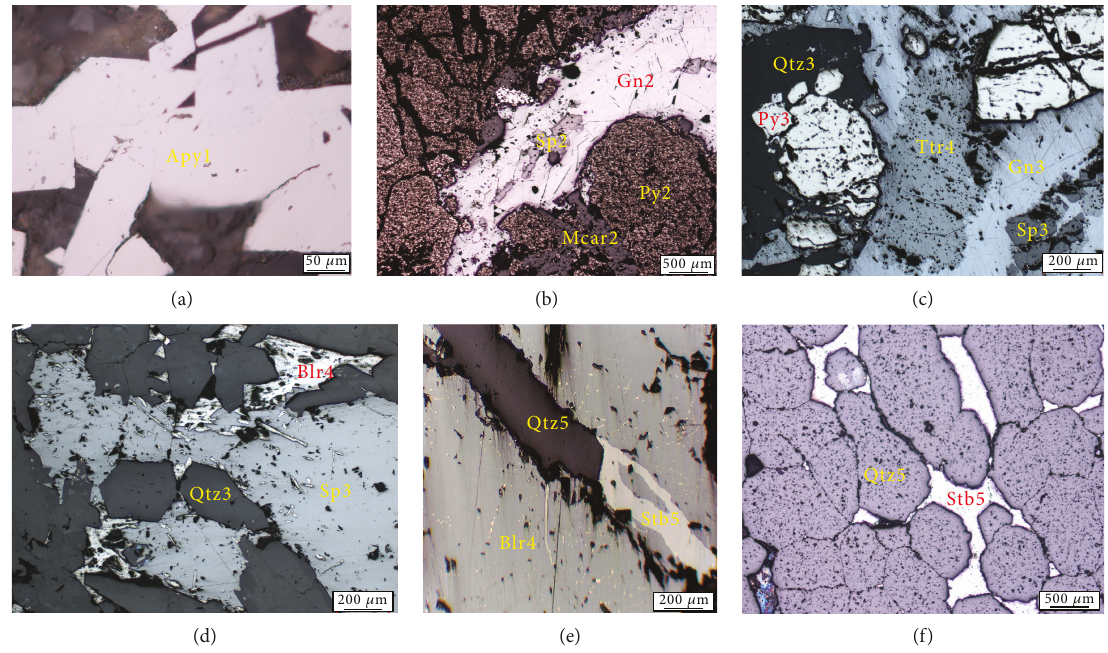
Figure 5: Photomicrographs of representative samples from the Keyue Sb – Pb – Zn – Ag deposit. (a) Assemblage 1 automorphic arsenopyrite. (b) Later formed assemblage 2 galena cut and replaced early formed sphalerite – pyrite – Mn – Fe carbonate. (c) Assemblage 4 tetrahedrite replaced assemblage 3 pyrite – sphalerite – galena – quartz. (d) Assemblage 4 boulangerite replaced assemblage 3 sphalerite – quartz. (e) Assemblage 5 quartz – stibnite vein cut the assemblage 4 boulangerite. (f) Assemblage 5 stibnite occurred among xenomorphic quartz grains. Abbreviations are the same as in Figure